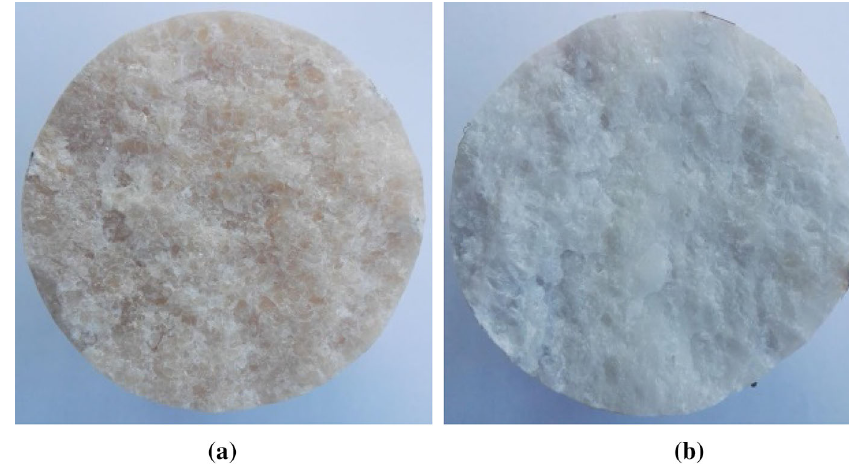
Fig. 3 Photographs of fracture surface for two marble specimens. a Specimen A2, b specimen B3